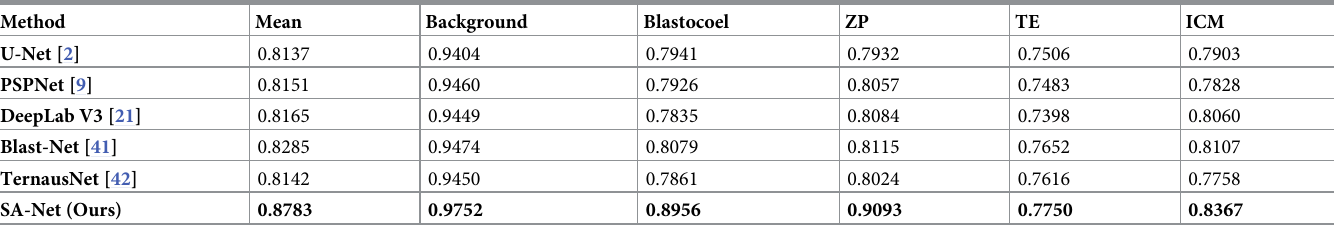
Table 4. Blastocyst segmentation performance measures on the blastocyst dataset.